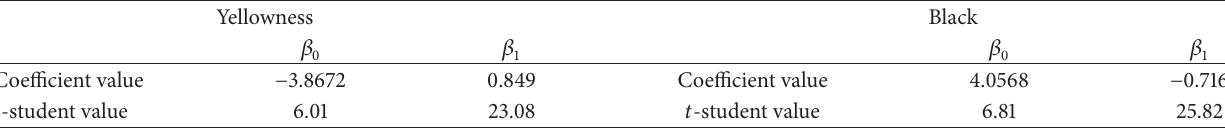
Table 1: Estimated parameters of the “yellowness” and “blackness” membership